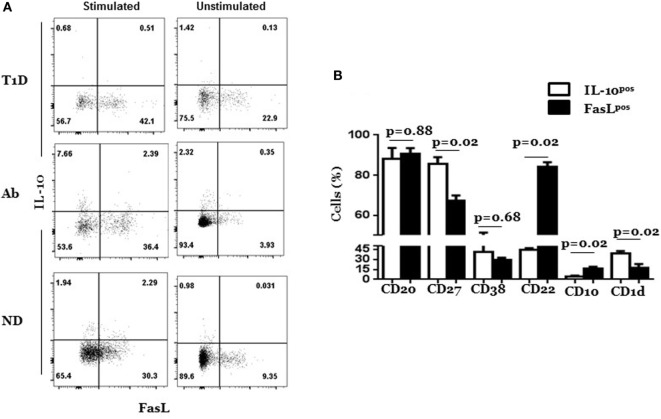
Most FasLhi CD5+ B cells do not produce IL-10 and exhibit less antigen-experience than IL-10pos CD5+ B cells. Cryopreserved splenocytes from type 1 diabetes (T1D), Ab+, and ND subjects were thawed and cultured in the presence or absence of phorbol myristate acetate and ionomycin for 6 h and analyzed simultaneously for surface expression of FasL and intracellular IL-10 as described under Section “Materials and Methods.” (A) Representative dot plots show expression of IL-10 and FasL by gated CD5+ B cells among stimulated and unstimulated cultures from T1D, Ab+, and ND subjects. Of note, the T1D dot plot was from the donor with the highest level of IL-10 expression so that the differential expression of FasL and IL-10 is better seen. (B) Graph shows expression of indicated surface molecules on gated IL-10pos and FasLhi subpopulations of CD5+ cells from stimulated cultures. Data are pooled from two independent experiments and four individually analyzed T1D subjects. Data were analyzed using the Mann–Whitney test and expressed as mean ± SEM; p < 0.05 is statistically significant.